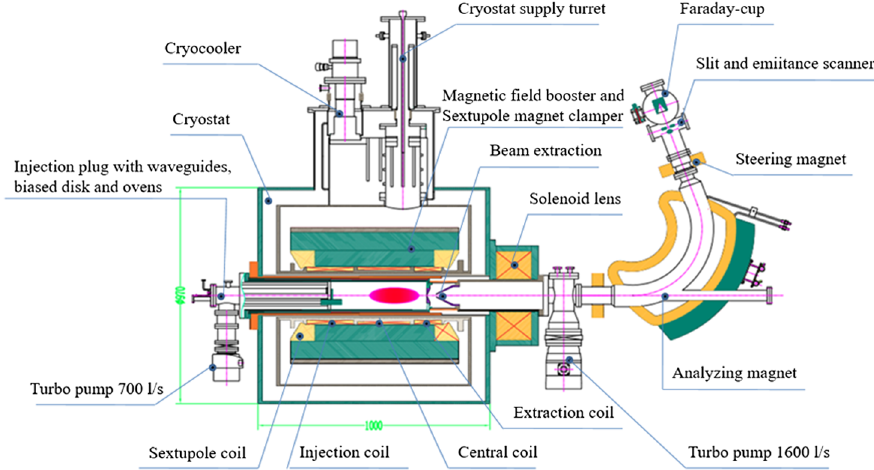
FIG. 2. Layout of the SECRAL ion source and its beam transport line.